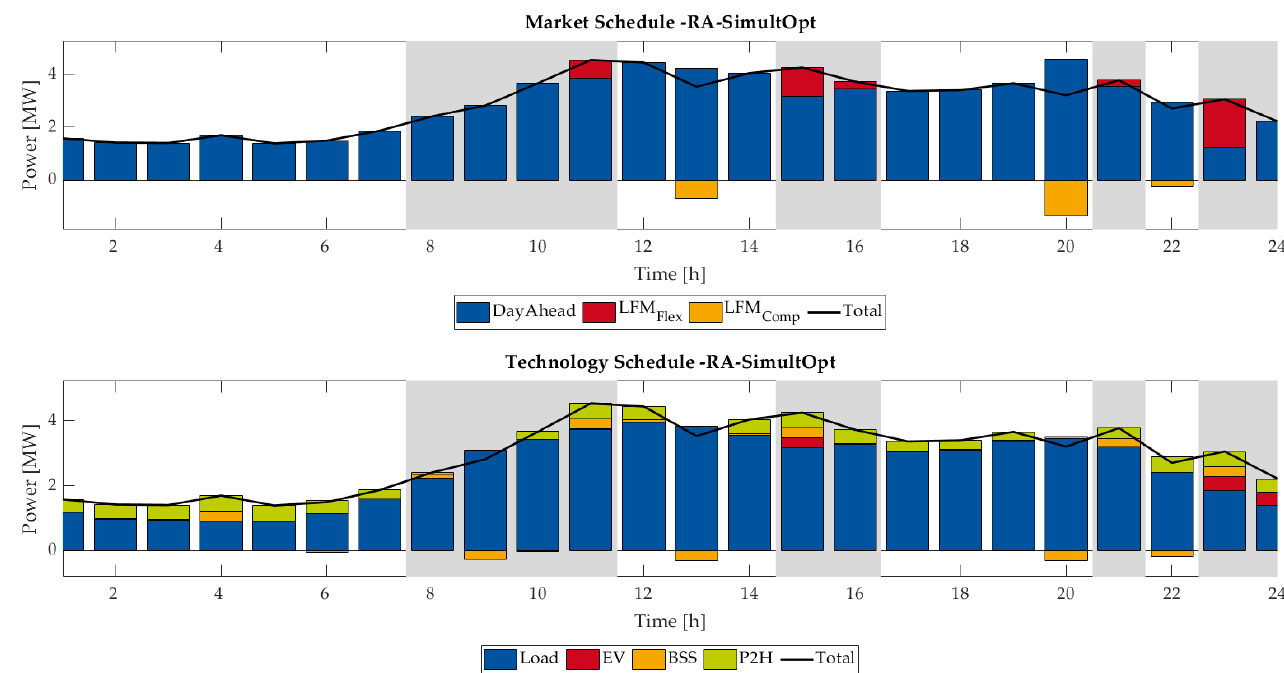
Figure 15. Schedules of operational planning RA-Simultopt of EMS at node 3 (Congestion times shaded in